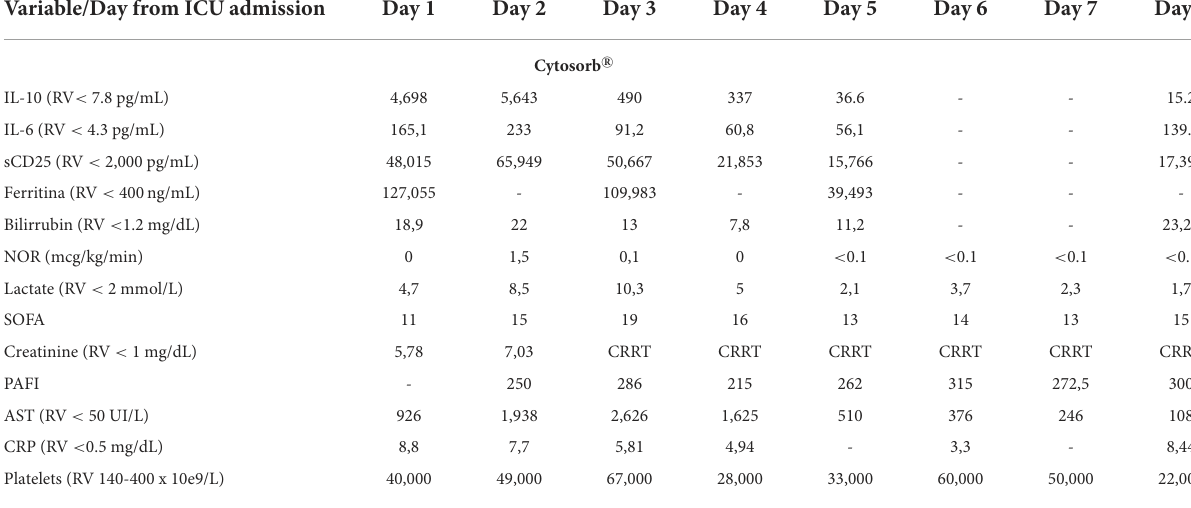
TABLE 1 Biochemical and clinical parameters. Variable/Day from ICU